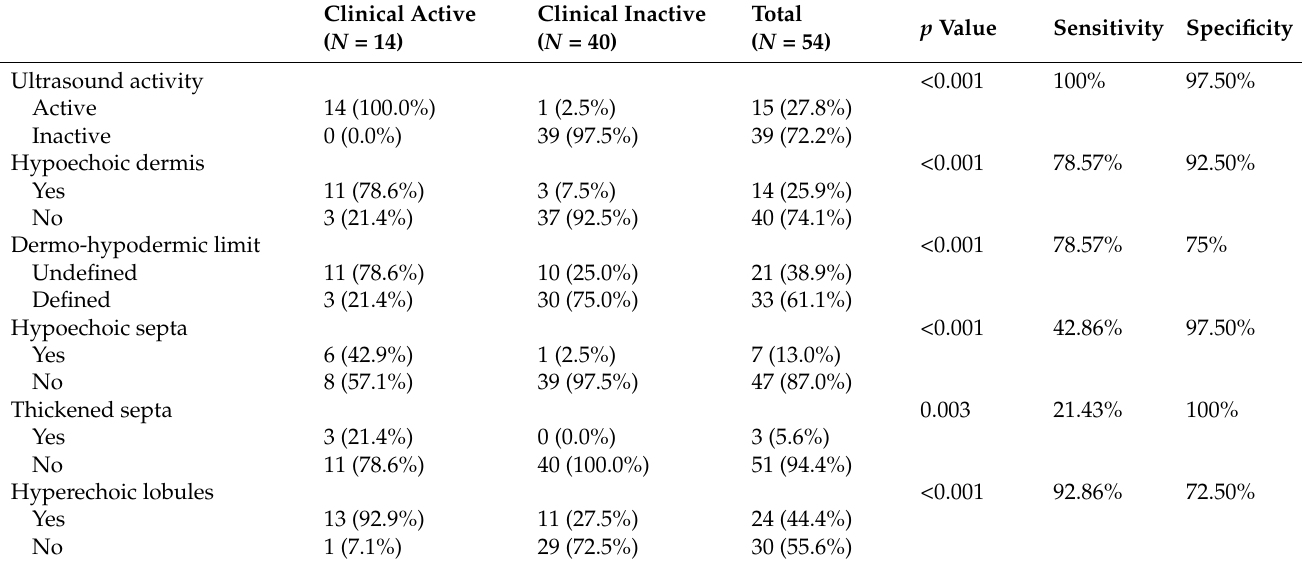
Table 2. Baseline HFUS characteristics of patients with connective tissue